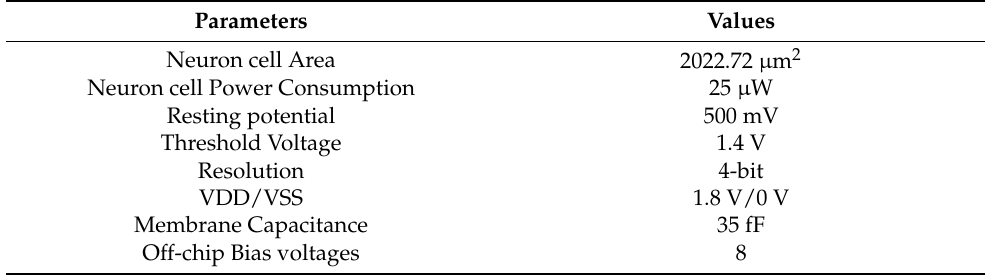
Table 1. Neuron Cell Simulation